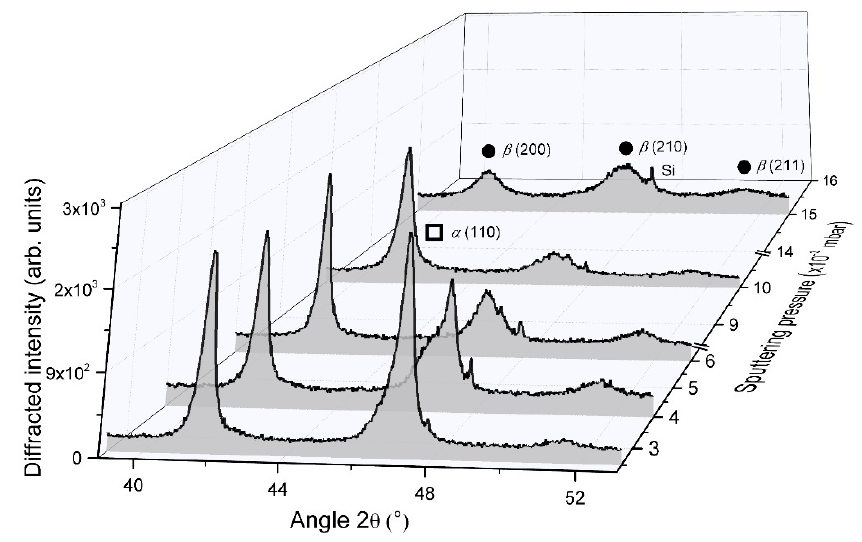
Figure 7. XRD patterns of 400 nm thick W thin films sputter-deposited on (100) Si substrate with an angle α = 80 ◦ , and for an argon sputtering pressure changing from 2.5 × 10 − 3 to 15 × 10 − 3 mbar. Diffracted signals show the occurrence of α and β phases ( π and λ , respectively).